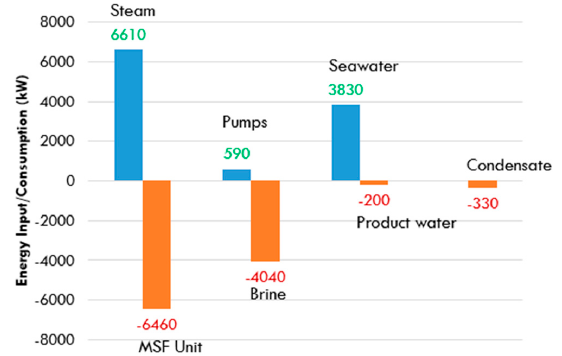
Figure 4. Exergy input and destruction in an MSF plant. Table 3. Exergy performance in MSF processes.